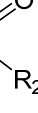
Figure 1. Isoxazol ‐ 5(4H) ‐ ones.